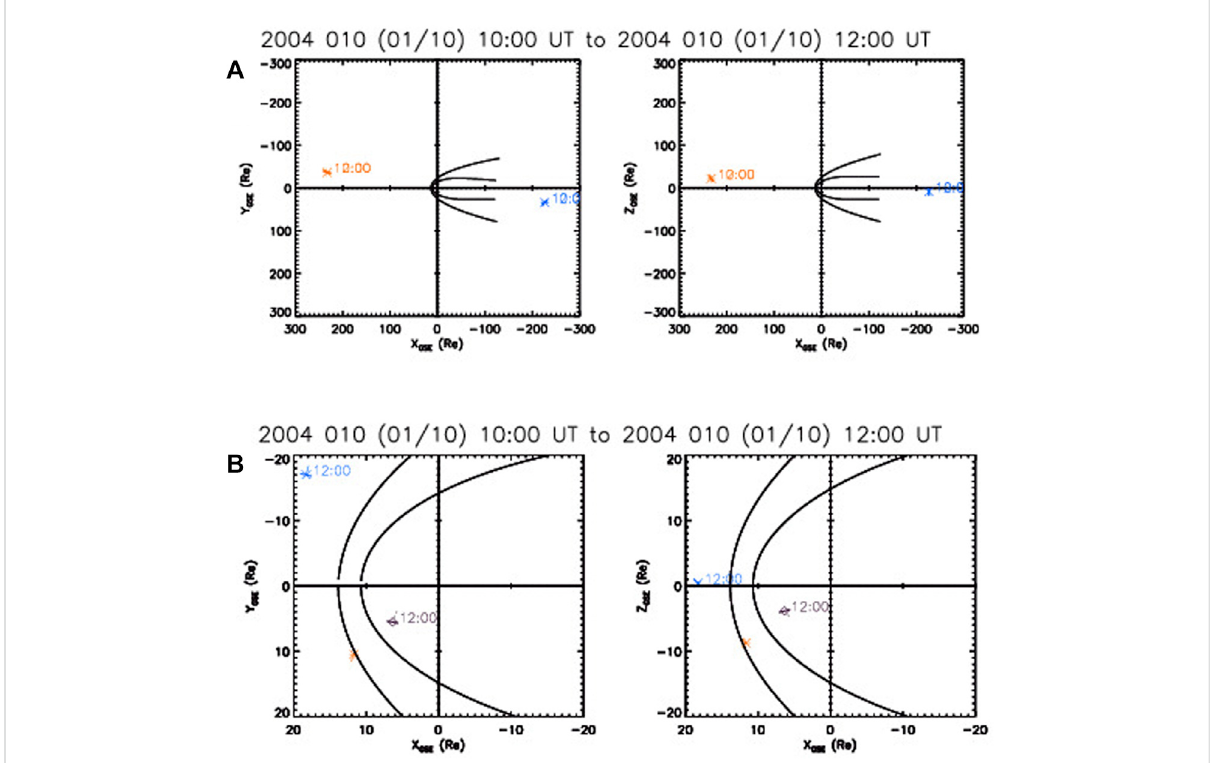
FIGURE 4 The positions of the spacecraft at 11 UT. (A) (top): ACE (red) upstream of Earth near the L1 point and Wind (blue) in the distant tail. (B) (bottom): The near-magnetopause spacecraft:blue:Geotail, red: Cluster 1,purple: Polar.The left-hand panels show the XY GSE plane while those on theright hand show the XZ GSE plane. The curves show model bow shock and magnetopause